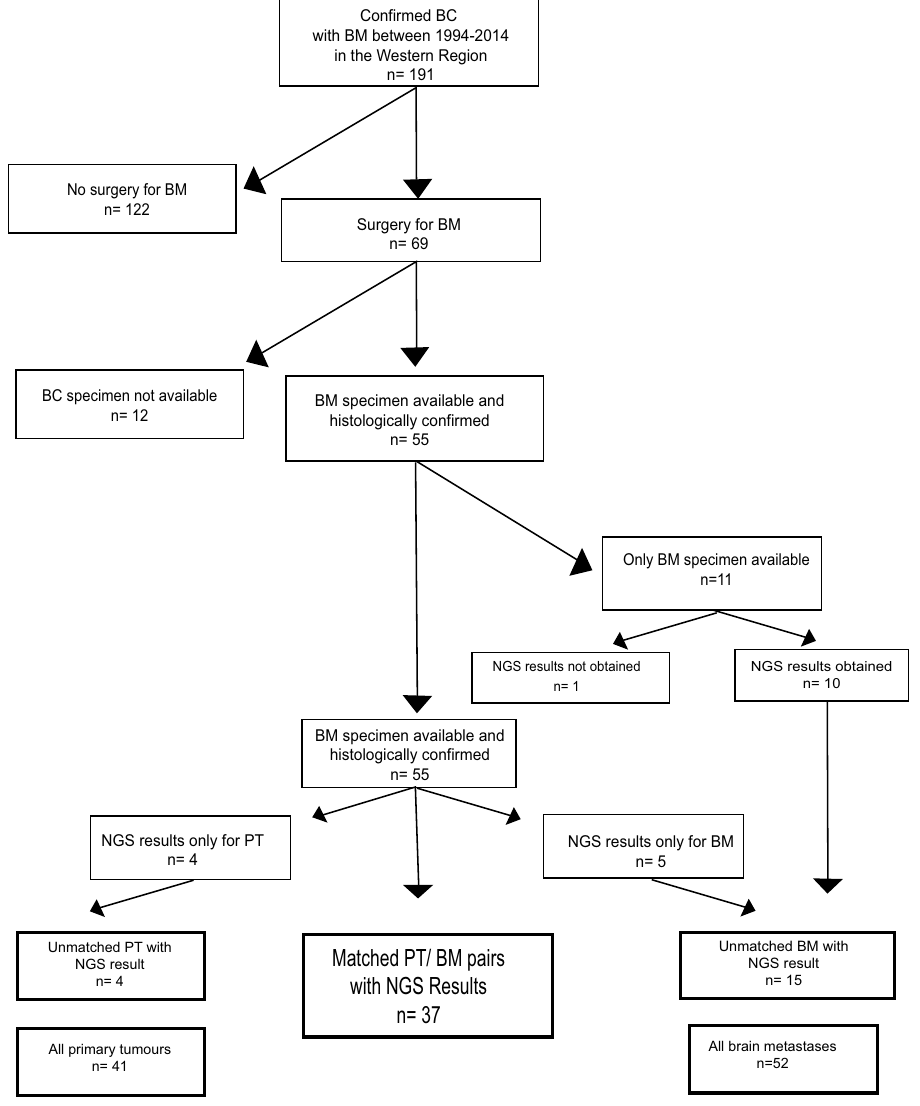
Figure 1. Consolidated Standards of Reporting Trials (CONSORT) diagram describing the identification process of the study population showing the final numbers of brain metastasis, primary breast tumors and matched pairs of brain metastasis and primary breast